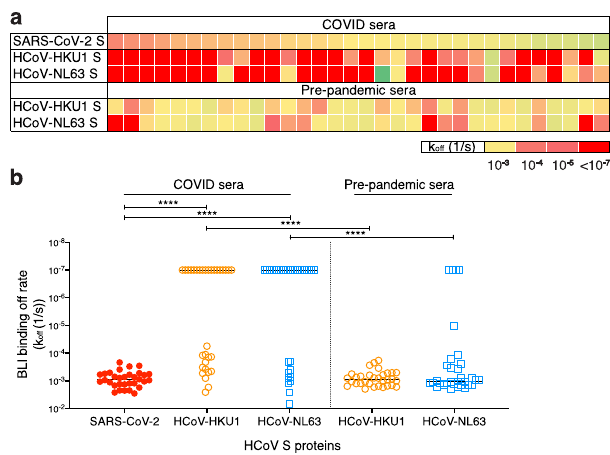
Fig. 2 BioLayer interferometry binding of COVID and pre-pandemic serum antibodies to SARS-CoV-2 and endemic HCoV S-proteins. a Heatmap summarizing the apparent BLI binding off-rates ( k off (1/ s )) of the COVID and pre-pandemic human serum antibodies to SARS-CoV-2 S and endemic β -HCoV, HCoV-HKU1 and α -HCoV, HCoV-NL63 S-proteins. Biotinylated HCoV S-proteins (100 nM) were captured on streptavidin biosensors to achieve binding of at least one response unit. The S-protein- immobilized biosensors were immersed in 1:40 serum dilution solution with serum antibodies as the analyte and the association (120 s; 180 – 300) and dissociation (240 s; 300 – 540) steps were conducted to detect the kinetics of antibody-protein interaction. k off (1/ s ) dissociation rates for each antibody – antigen interaction are shown. b Off-rates for binding of serum antibodies from COVID donors and from pre-pandemic donors to SARS- CoV-2 S and endemic HCoV, HCoV-HKU1, and HCoV-NL63, S-proteins. Signi fi cantly lower dissociation off-rates are observed for COVID compared with pre-pandemic sera. Statistical comparisons between the two groups were performed using a Mann – Whitney two-tailed test, (**** p <